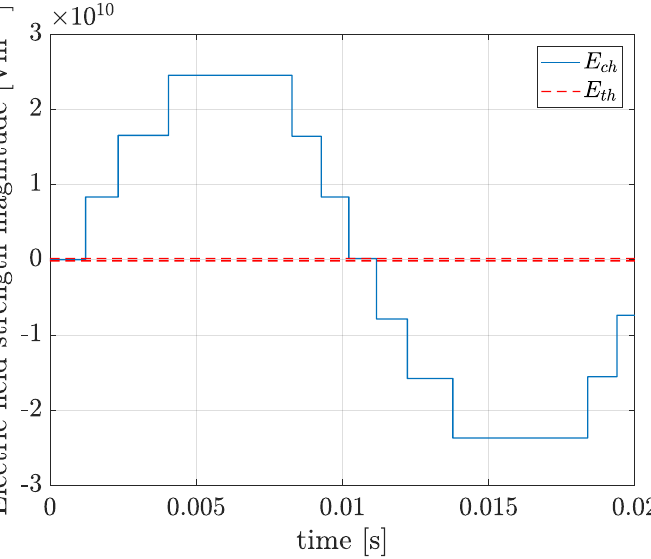
E (V ‧ m⁻ 1 ) is the electric field q (V ‧ m⁻ 1 ) is the resultant electric field